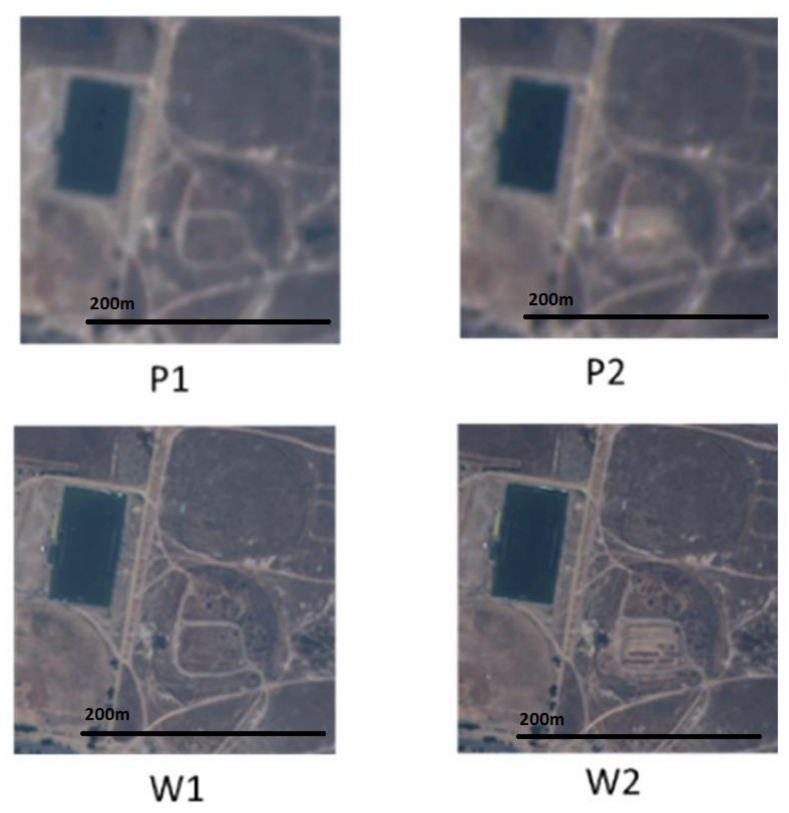
Figure 2. Relationship between two pairs of Planet (top row) and Worldview-2 (WV) (bottom row) images. Table 2. Means and stds of Green band of two image pairs for the three scenarios in Section 3. Image